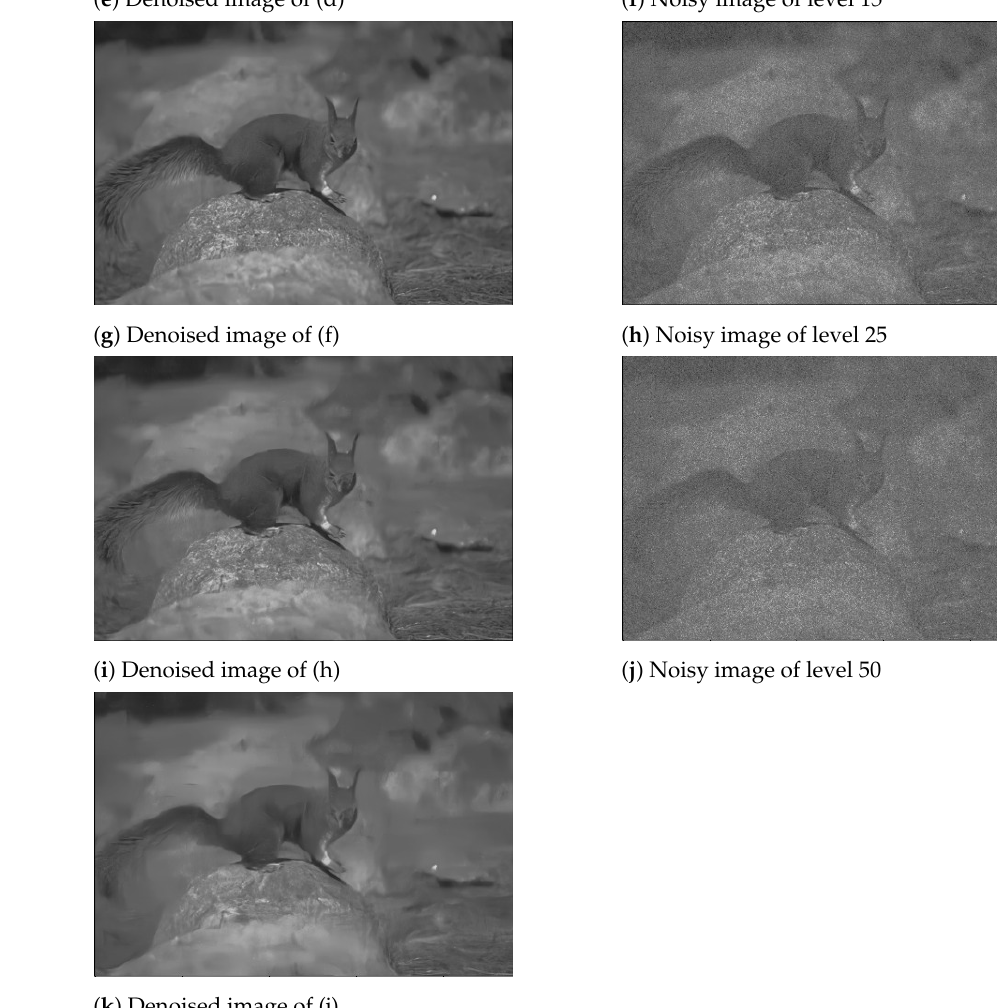
Figure 3. Noisy and denoised versions of the original